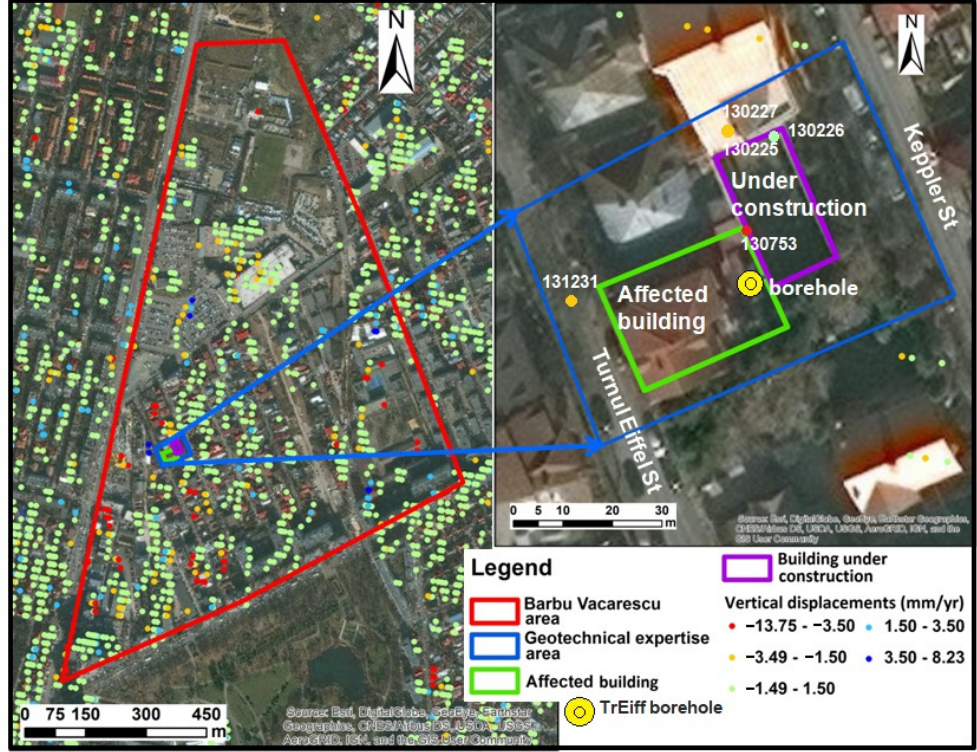
Figure 14. Study case on a building situated in the Barbu Vacarescu area. Blue color line limit marks the area of the stability-geotechnical expertise. Green color line is the limit of the affected building. Purple color line is the limit of the building under construction. PSI velocity map is generated from Sentinel-1 109 Descending orbit data. Codes of PS points situated inside the studied area are marked on the map. Map generated in Esri ® ArcMap™ 10.3. Base map source: ESRI World Imagery.